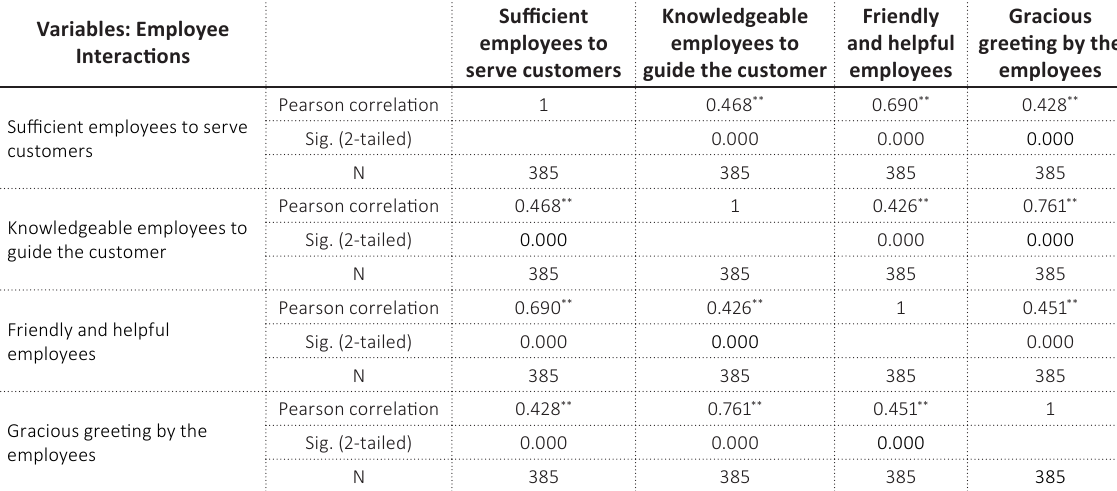
Table 5. Correlation between the variables of employee interactions